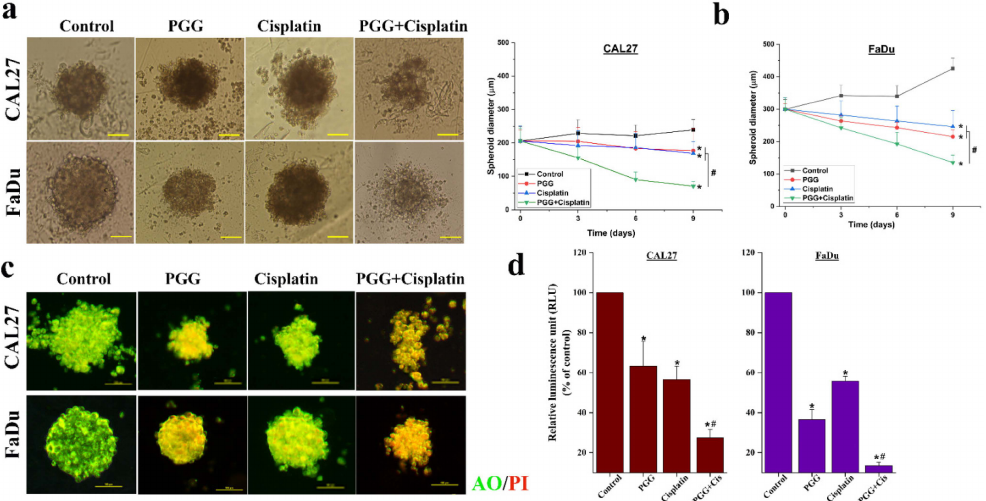
Figure 8. Effects of PGG combined with cisplatin on cell viability in the 3D HNSCC cancer cell culture. The effect of 50 µ g/mL PGG, 10 µ g/mL cisplatin, and their combination on CAL27 and FaDu multicellular spheroids after 72, 144, and 216 h of treatment. ( a ) Typical images of CAL2 and FaDu multicellular spheroids after 216 h of control or treatment with PGG, cisplatin, and their combination. Scale bar = 100 µ m. ( b ) The spheroid size was calculated from three independent experiments ( n = 3) measuring the size of eight spheroids for each condition. Data are expressed as mean ± SD. ( c ) AO/PI staining revealed the apoptosis induction in 3D spheroids treated with 50 µ g/mL PGG, 10 µ g/mL cisplatin, and their combination on CAL27 and FaDu multicellular spheroid for 72 h. Scale bar = 100 µ m. ( d ) Relative ATP content (% of control) at day 9 of CAL27 and FaDu multicellular spheroid. All data are expressed as the mean ± SD of three independent experiments. * p < 0.05: significantly different from control, and # p < 0.05: significantly different from PGG and cisplatin treatment alone. PGG, pentagalloyl glucose; Cis,